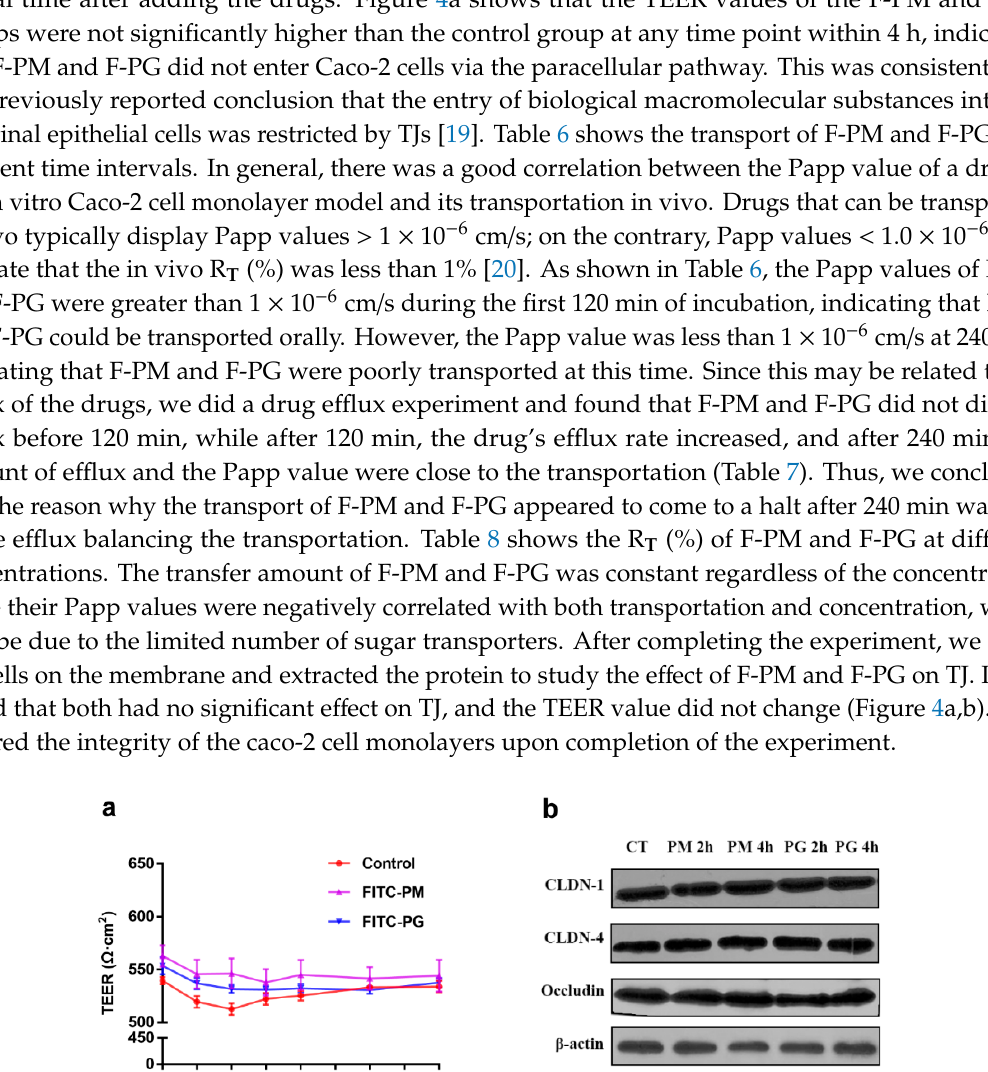
Table 7. The efflux experiments with F-PM and F-PG. Time (min)